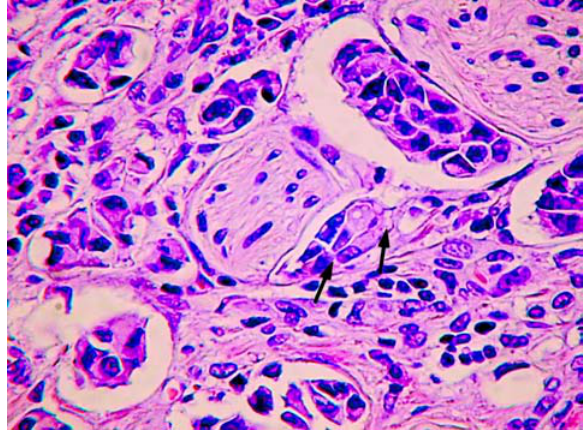
Figure 1 – Perineural invasion by the transitional cell carcinoma of the bladder